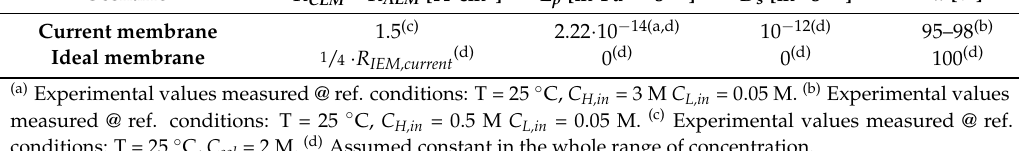
Table 2. Membrane properties adopted in the two scenarios current and ideal membranes [45]. Scenario Current